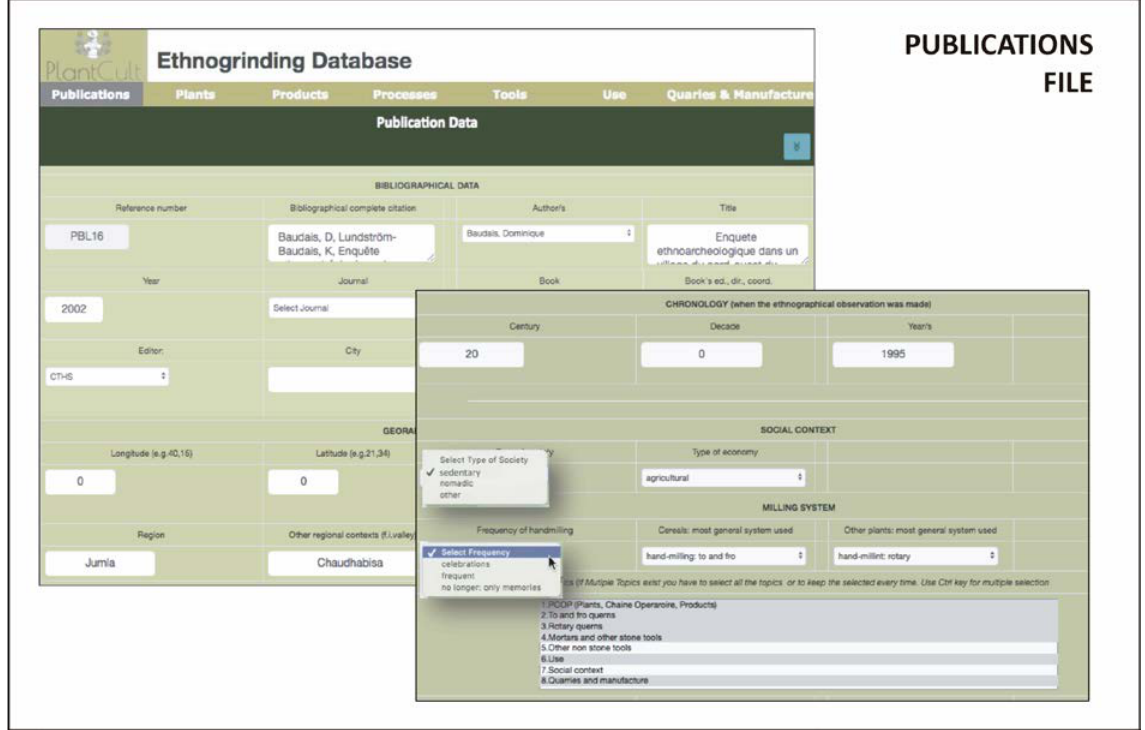
Figure 3. The Publications